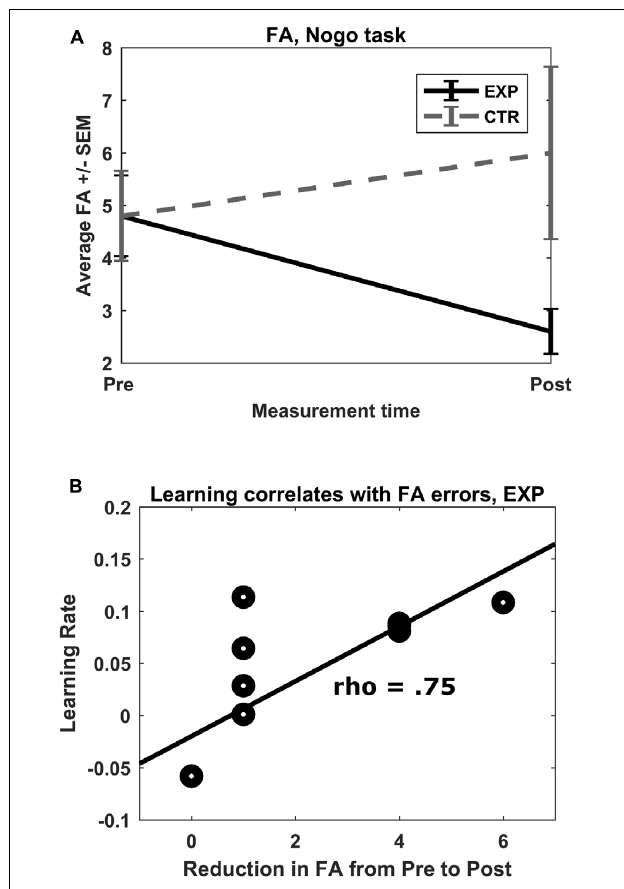
FIGURE 4 | (A) No-go FA errors. Mean total FA errors for the no-go condition shown for both groups for both pre- and post-test. ∗ p = 0.01. (B) Rate of learning correlation with FA reduction. In the experimental group, there was a strong correlation between rate of learning of the feedback parameter (prefrontal oxygenation) and pre–post reduction in FA errors